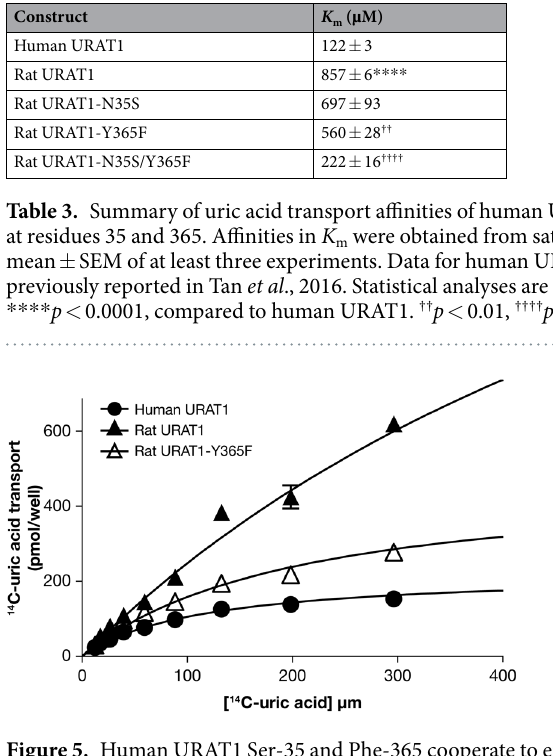
Figure 5. Human URAT1 Ser-35 and Phe-365 cooperate to enhance urate affinity. Transport kinetics of human URAT1 (filled circles), rat URAT1 (filled triangles) and the double point mutant chimera rat URAT1 carrying human URAT1 residues at 35 and 365 (r-N35S/F365Y, open triangles). Data are from one representative experiment presented as the mean ± SEM of samples measured in triplicate. The half maximal transport velocity ( K m ) for each construct is presented in Table